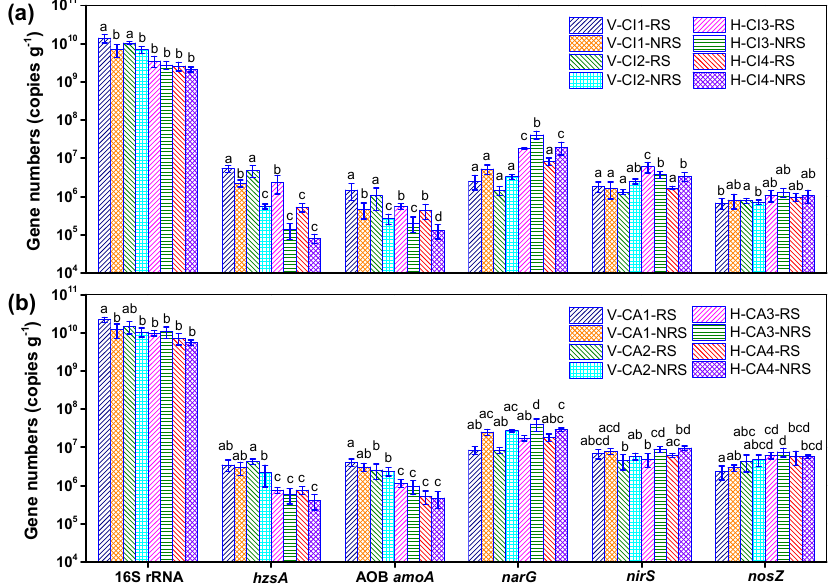
Figure 5. Quantitative analysis of microbial 16S rRNA and functional genes in the RS and NRS in VSFCW and HSFCW. ( a ) Canna indica (CI); ( b ) Cyperus alternifolius (CA). Error bars represent standard deviation calculated from three independent experiments. The samples numbers were shown in Figure 2.